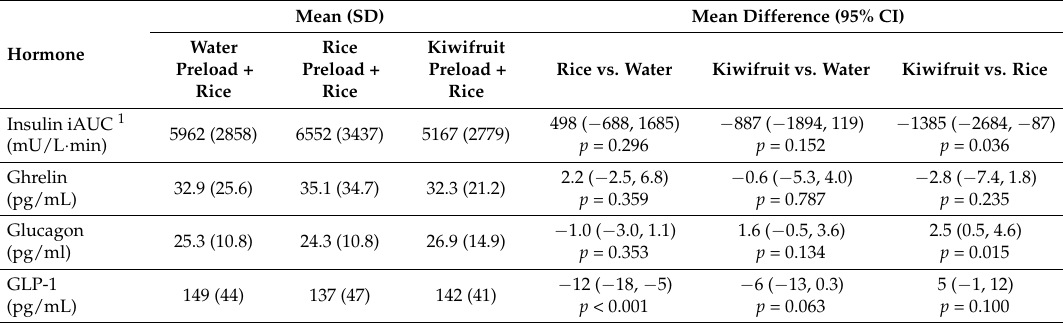
Table 3. Mean postprandial hormonal responses to breakfast treatments (preloads and meals combined) over 150 min ( n =